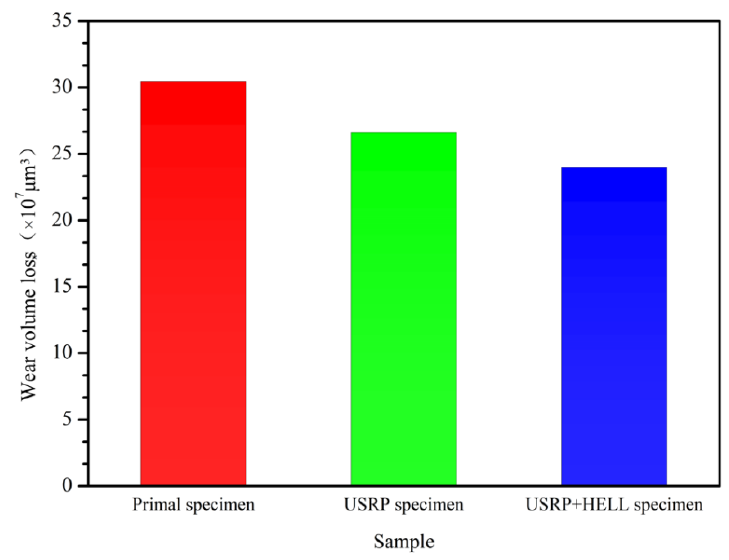
Figure 4. Wear volume loss of samples with different treatment processes.